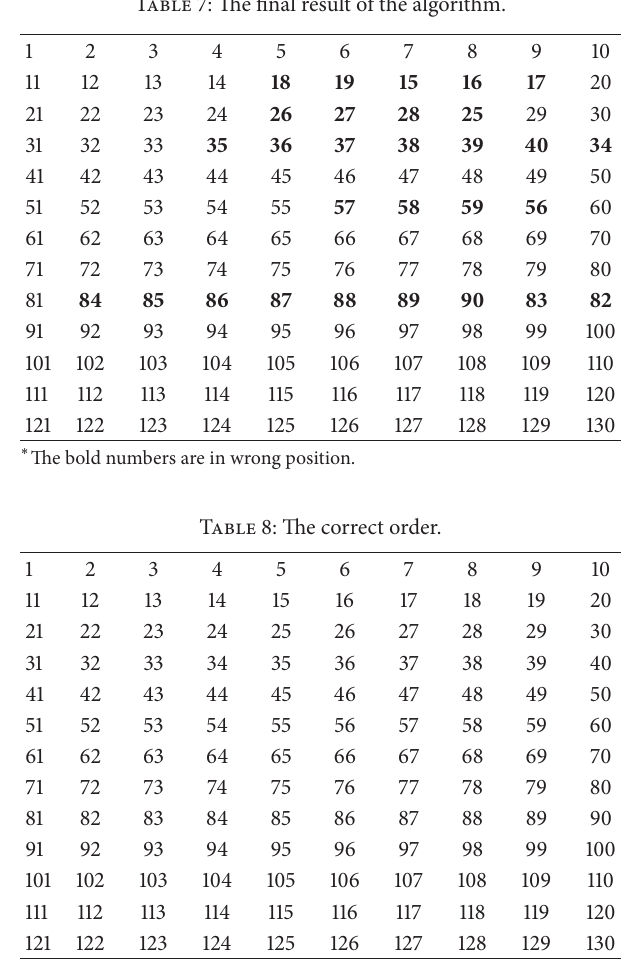
Table 7: The final result of the algorithm.